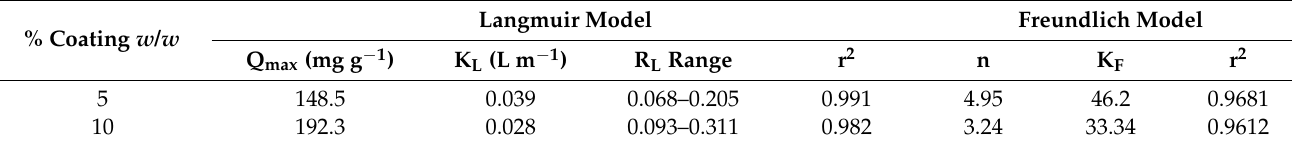
Table 2. Isotherm constants for the adsorption of Cu 2+ and Zn 2+ . Table 1. Isotherm constants for the adsorption of Cu 2+ . Langmuir Langmuir Model